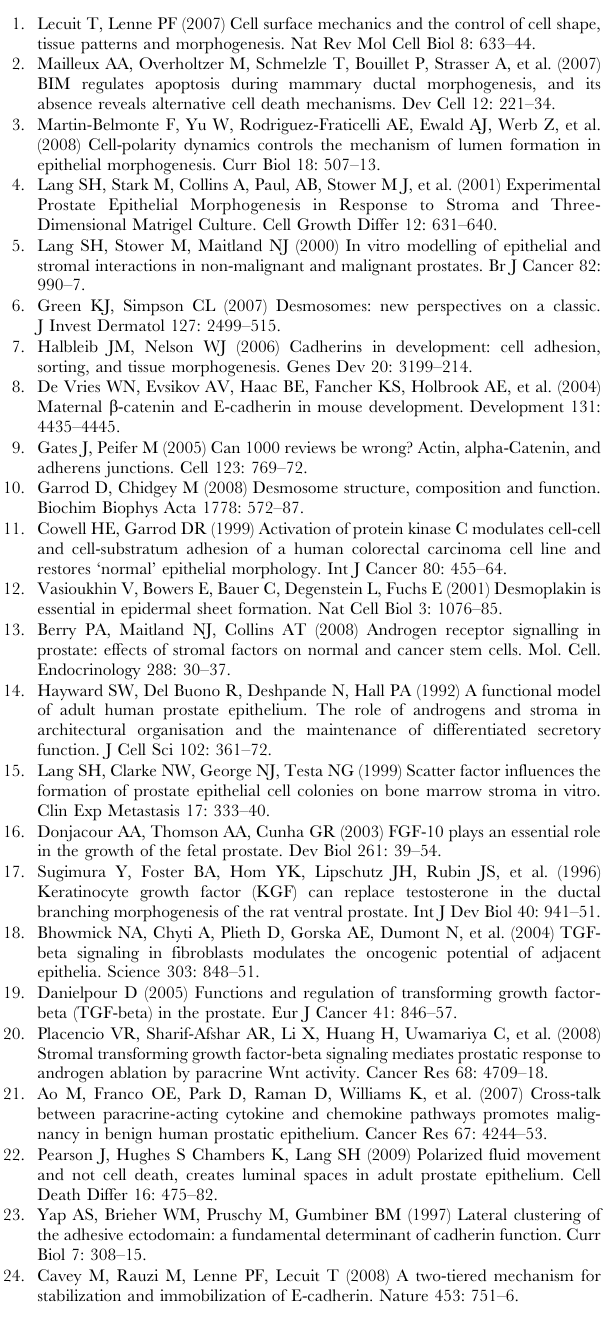
Table S5 Secondary antibodies and dilutions for im- munofluorescence and Western blotting. Table S6 Primers for RT-PCR. (DOC) Table S7 Primers and probes for real time RT-PCR.